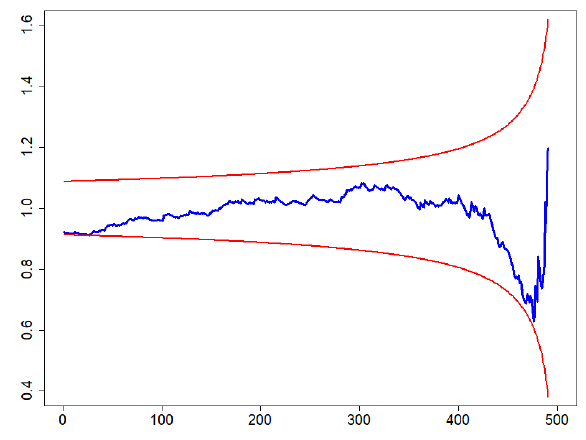
Figure 3. Example of CV